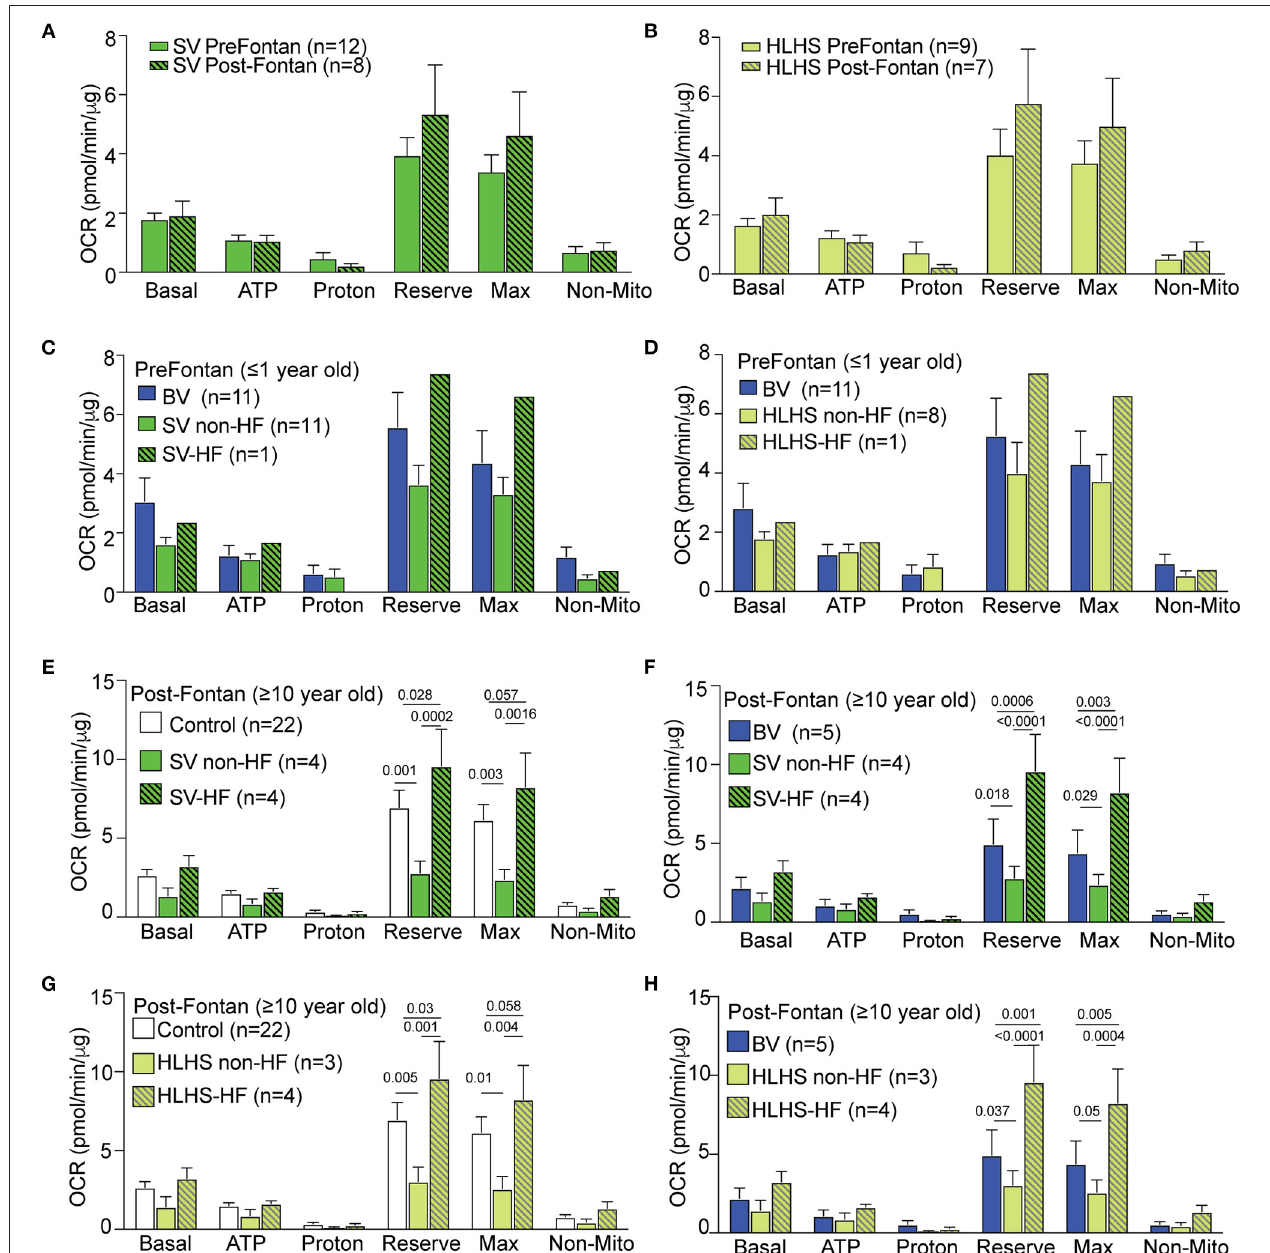
FIGURE 2 | Mitochondrial respiration in SV-CHD patients stratified by Fontan palliation and HF status. (A,B) No significant difference was observed for respiration in pre- vs. post-Fontan SV and HLHS patient groups. (C,D) Mitochondrial respiration in the PMBCs of pre-Fontan SV (C) or HLHS patients (D) ≤ 1 year old as compared to age-matched BV patients. (E,F) Mitochondrial respiration in the PBMCs of SV-CHD patients ≥ 10 years old with and without HF vs. age-matched controls (E) and BV-CHD patients (F) . (G,H) Mitochondrial respiration in the PBMCs of HLHS-CHD patients ≥ 10 years old with and without HF vs. age-matched controls (G) and BV-CHD patients (H) . Mean ± SEM with one-way ANOVA test. Subjects’ numbers are indicated in the legend for the graphs. BV, biventricular; CHD, congenital heart disease; HF, heart failure; HLHS, hypoplastic left heart syndrome; OCR, oxygen consumption rate; PBMC, peripheral blood mononuclear cell; SV, single ventricle.